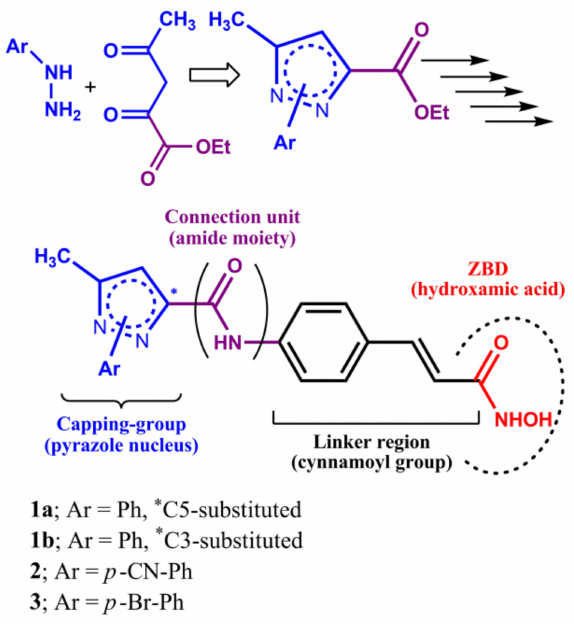
Figure 2. Design of the first set of HDACIs ( N 1 -aryl-pyrazole derivatives). For synthetic details, see Scheme S1.